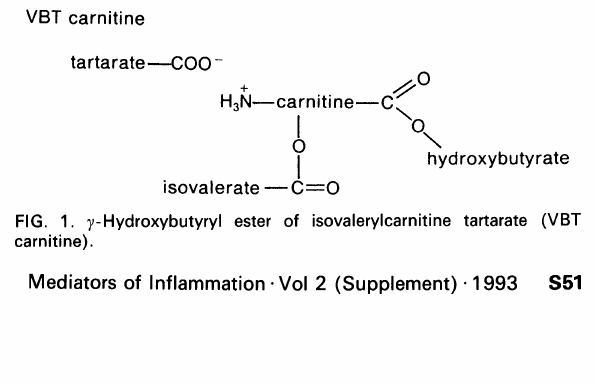
FIG. 1. y-Hydroxybutyryl ester of isovalerylcarnitine tartarate (VBT carnitine). Mediators of Inflammation.Vol 2 (Supplement).